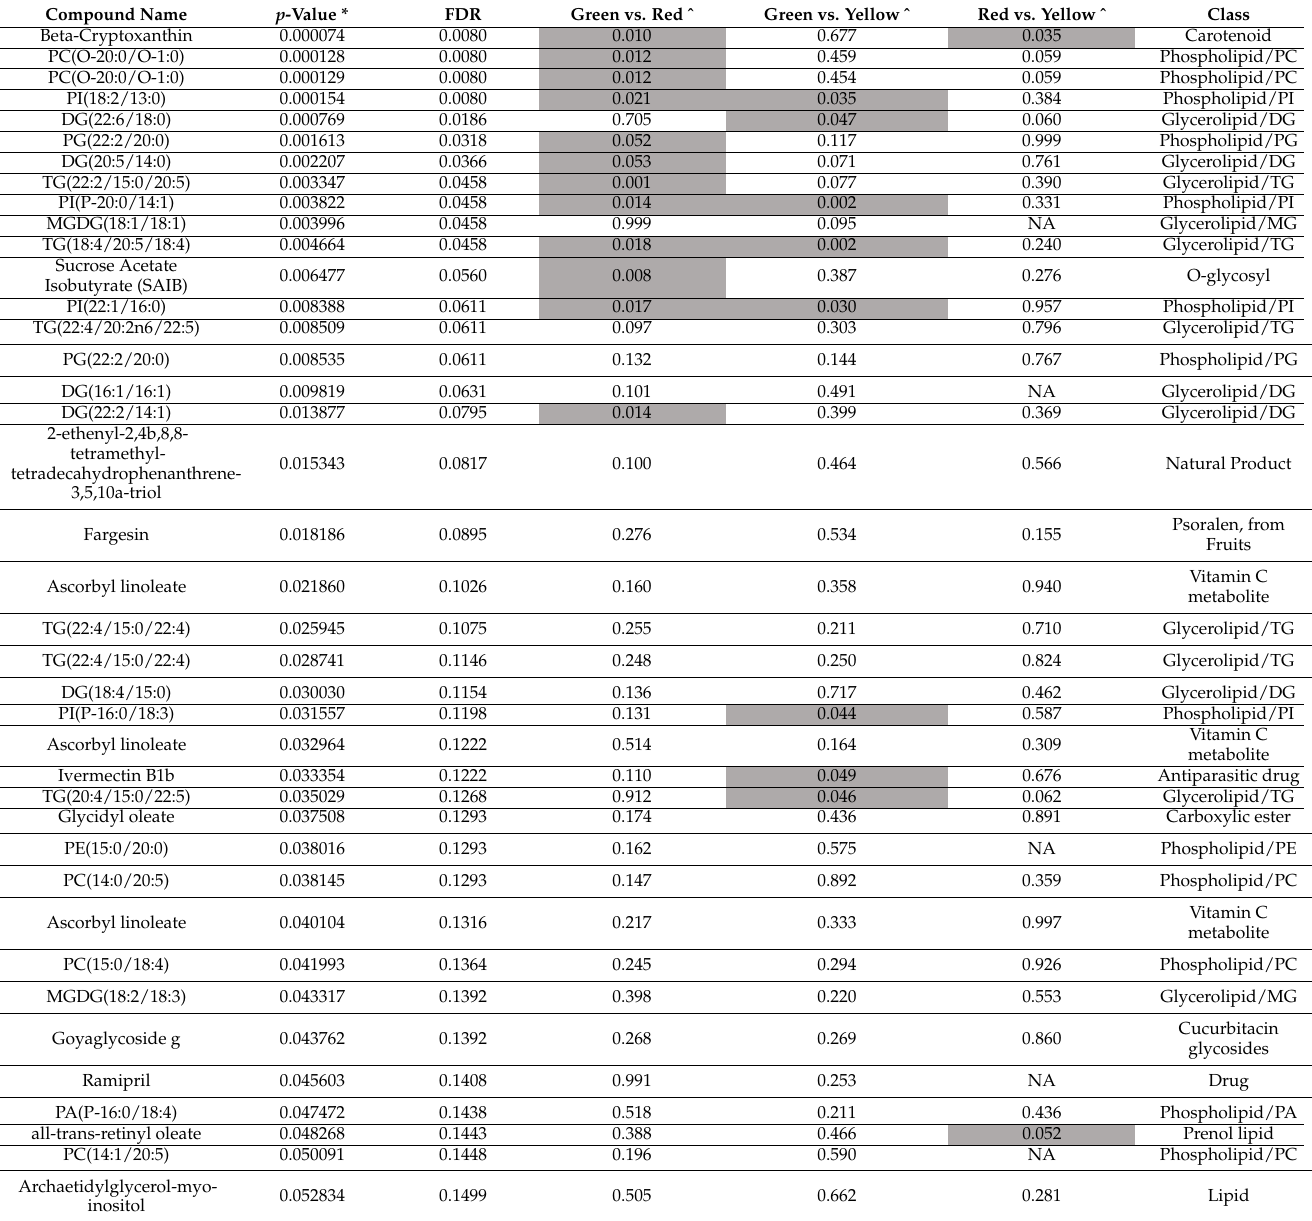
Table 1. Annotated pepper compounds nominally associated with